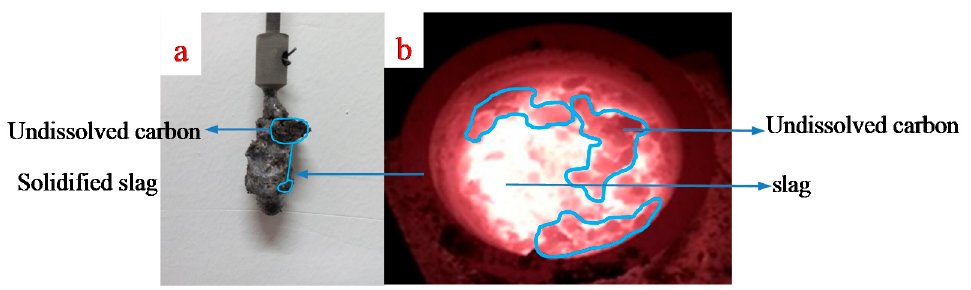
Figure 12. The molybdenum probe after experiment ( a ), and the slag in molten stage ( b ).